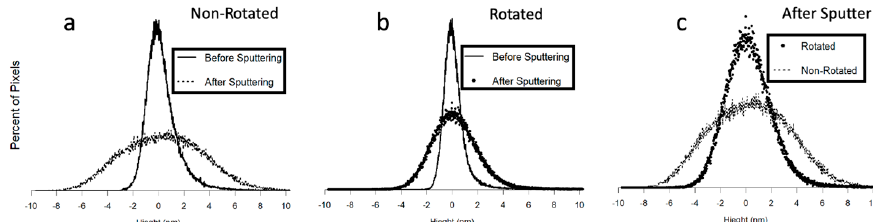
Figure 5. Zero centered pixel height distributions of AFM images from Figure 4 showing before and after sputtering a non-rotated sample ( a ); before and after sputtering, a rotated sample ( b ); and after sputtering a rotated and non-rotated sample ( c ). The root-mean-square (RMS) values in Figure 4 are the same as the standard deviations of the distributions here in Figure